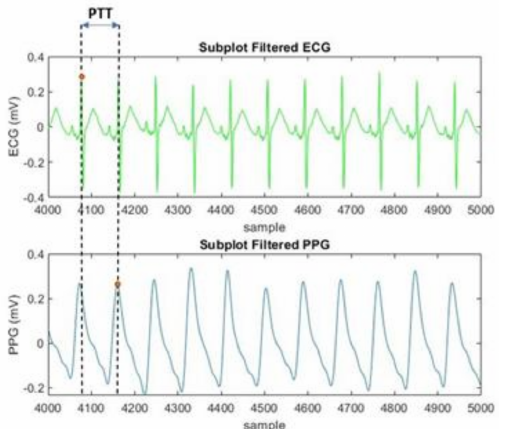
Figure 2. Time interval between R − peak and S −